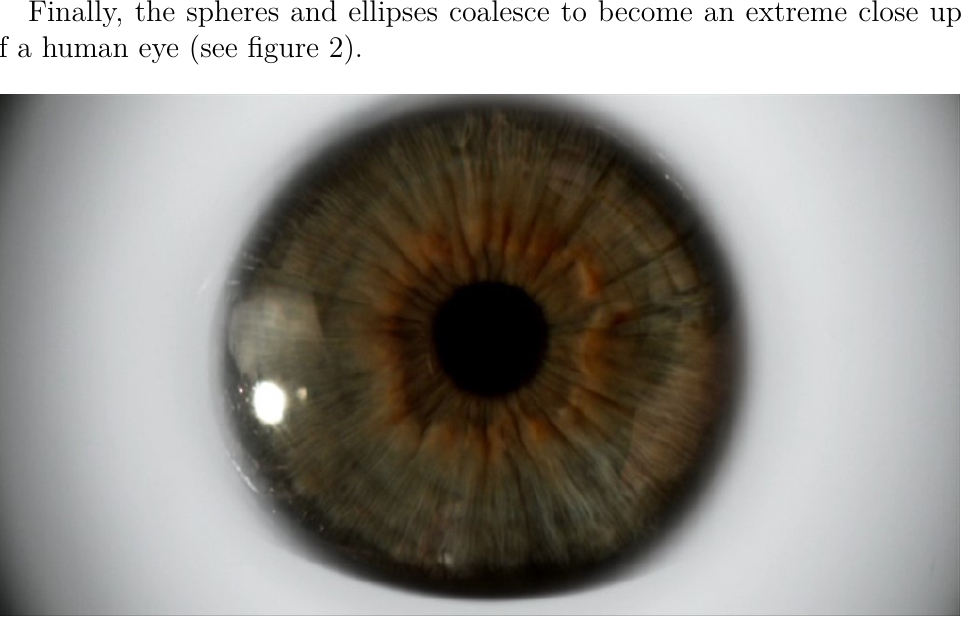
Figure 2: Under the Skin directed by Jonathan Glazer. 2013; London: BFI & Film 4.